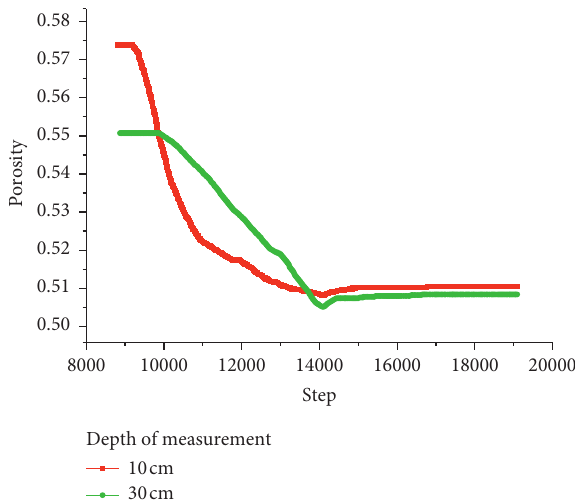
Figure 24: Curve of porosity change of 70 cm thick reclaimed soil with one compaction.